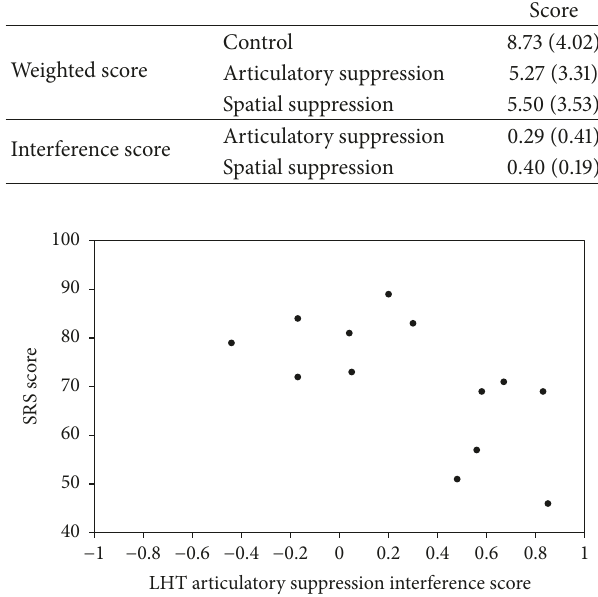
Figure 1: Scatterplot depicting the relation between the articulatory suppression interference score and SRS score in children with